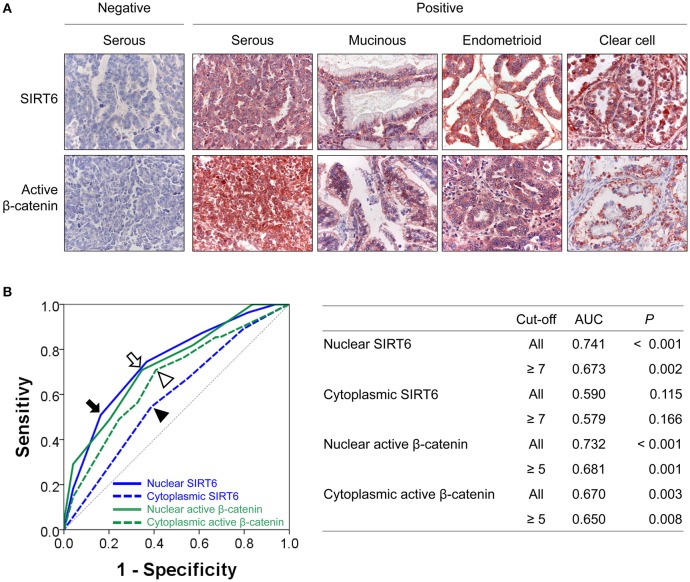
Immunohistochemical expressions of SIRT6 and active β-catenin, and statistical analysis in ovarian carcinomas. (A) Immunohistochemical expressions of SIRT6 and active β-catenin are seen in both the cytoplasm and nuclei of tumor cells. (B) Receiver operator characteristic curve analysis to determine the cut-off points for the immunohistochemical staining for SIRT6 and active β-catenin. The cut-off points were determined at the highest area under the curve (AUC) value. The cut-off points for nuclear expression of SIRT6 (arrow), cytoplasmic expression of SIRT6 (arrow head), nuclear expression of active β-catenin (empty head), and cytoplasmic expression of active β-catenin (empty arrow head) were seven, seven, five, and five, respectively. The table shows AUC and P values at cut-off points for the nuclear and cytoplasmic expressions of SIRT6 and active β-catenin.